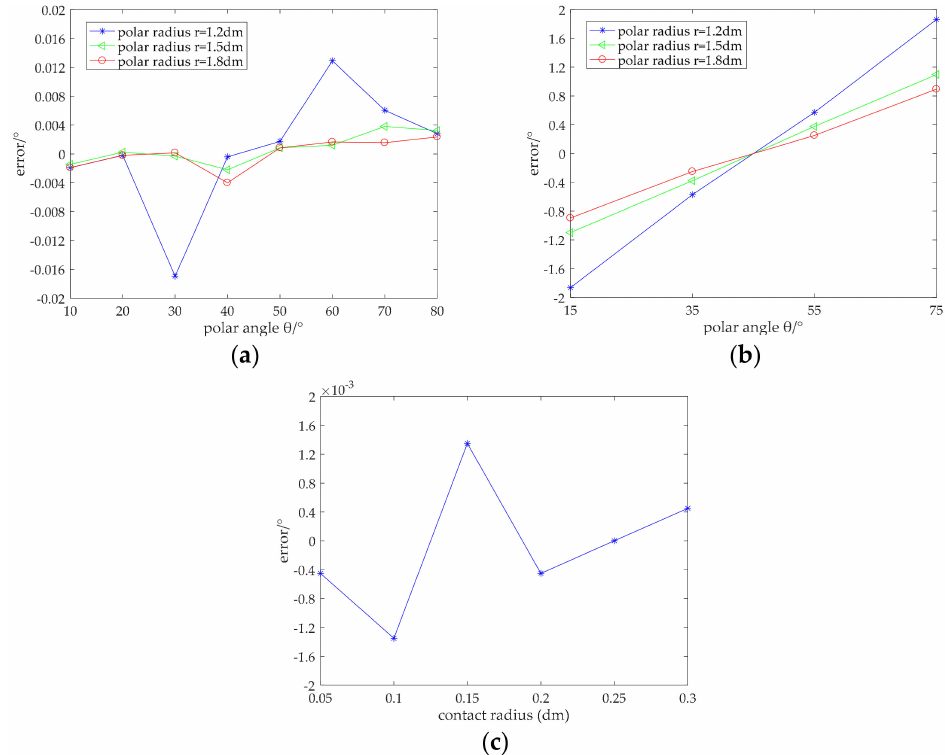
Figure 12. Detection precision for the polar angle: ( a ) error diagram of the polar angle under point contact; ( b ) error diagram of the polar angle under surface contact; ( c ) influence of the contact area on